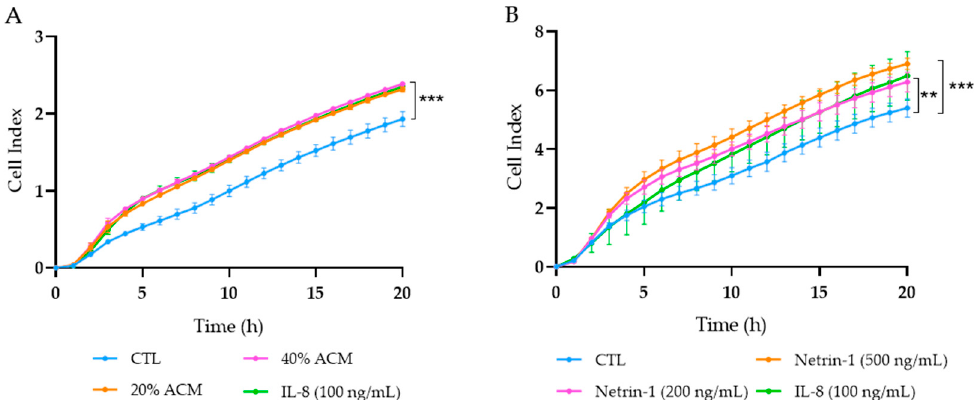
Figure 5. Migration of Caco-2 cells treated with ( A ) adipocyte conditioned media (ACM), ( B ) netrin-1 (NTN-1), and interleukin (IL)-8. RPMI media with 2% FBS was used as the baseline control (CTL), and IL-8 was the positive control of migration. Graphs represent the mean from four replicates in three different experiments. Differences between groups were analysed by one-way ANOVA followed by Dunnett’s post hoc tests. ** p < 0.01 and *** p < 0.001 vs. CTL.